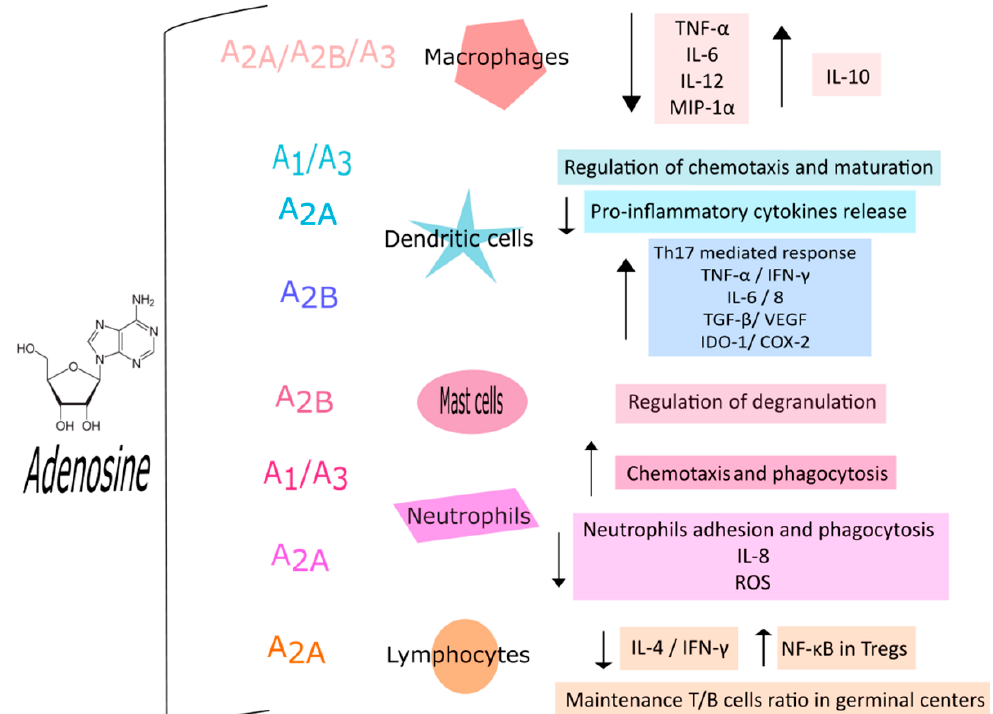
Figure 2. Schematic representation of main actions mediated by adenosine receptors (ARs) in human immune cells. Abbreviations: TNF- α : tumor necrosis factor α ; IL: interleukin; MIP: macrophage inflammatory protein; IFN- γ : interferon γ ; TGF- β : tissue growth factor β ; VEGF: vascular endothelial growth factor; IDO-1: indoleamine 2:3 dioxygenase; COX-2: cyclooxygenase 2; ROS: reactive oxygen species; NF- κ B: nuclear factor κ -light-chain-enhancer of activated B cells; ↑ : increase; ↓ : decrease.